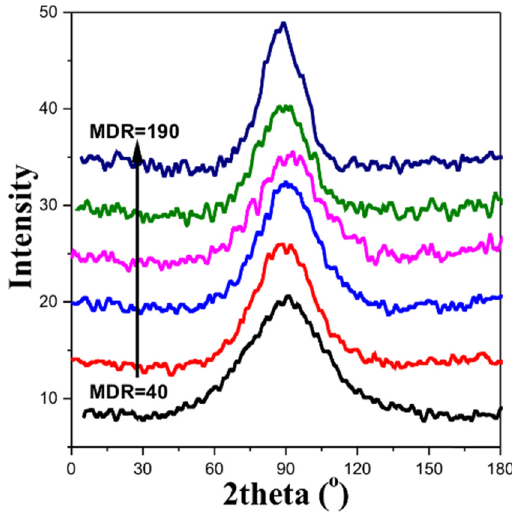
Figure A2: The intensity of the ( 200 ) plane at di ff erent